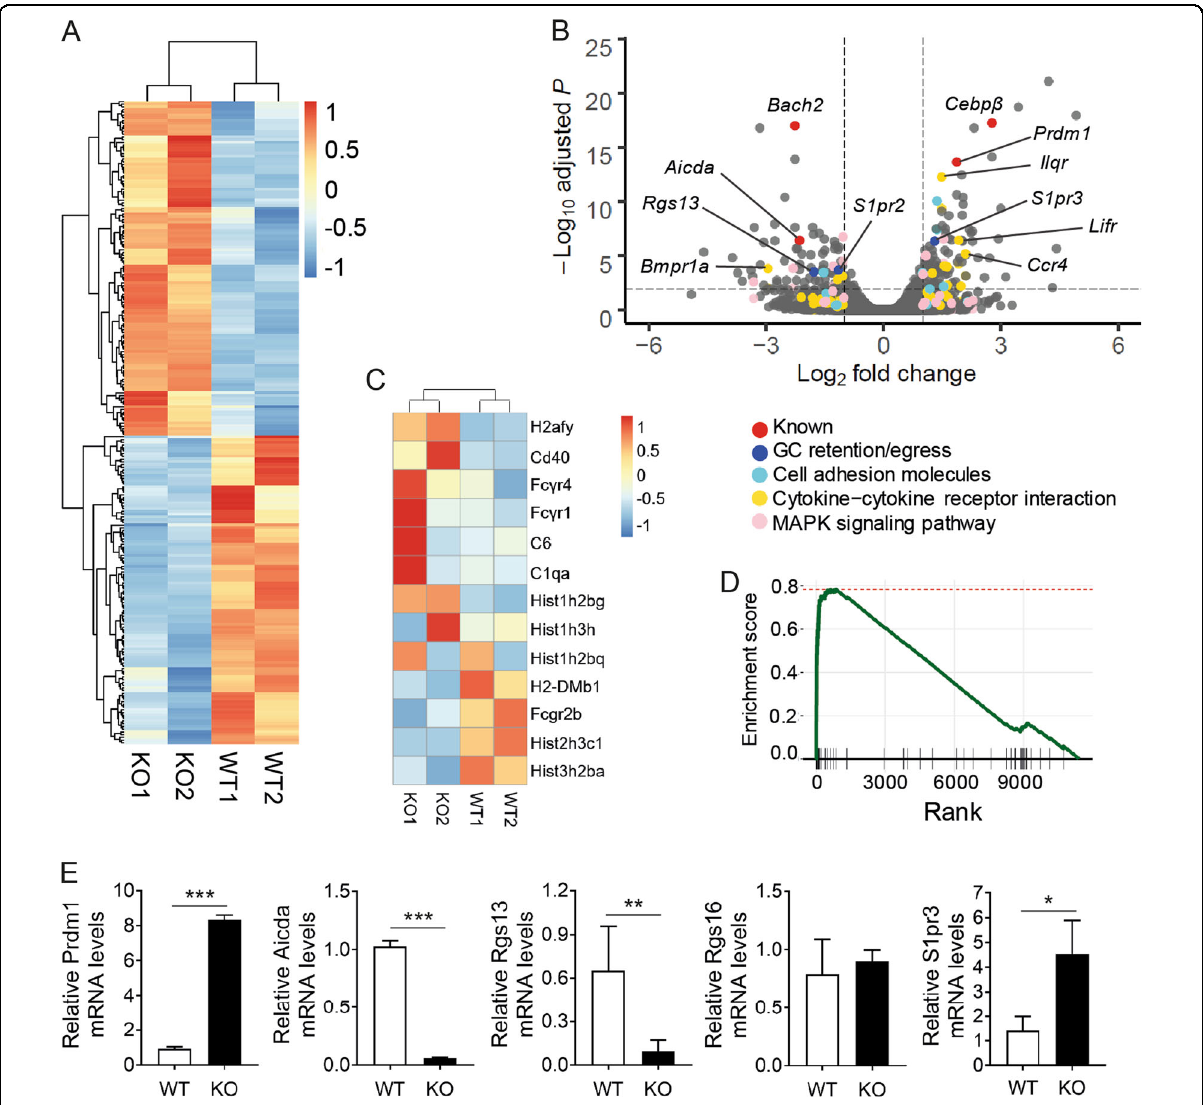
Fig. 3 Transcriptome analysis of Bach2-de fi cient and control B cells. a Heatmap of gene expression changes between Bach2 KO and WT B cells. b Volcano plot of gene expression changes between Bach2 KO and WT B cells. Genes involved in KEGG pathways are shown as indicated. c and d Heatmap and enrichment plot of genes in the KEGG pathway of SLE. e Quantitative RT-PCR to verify the RNAseq data. Graphs are representative of two independent experiments. * p < 0.05, ** p < 0.01 and *** p < 0.001 by Student ’ s t